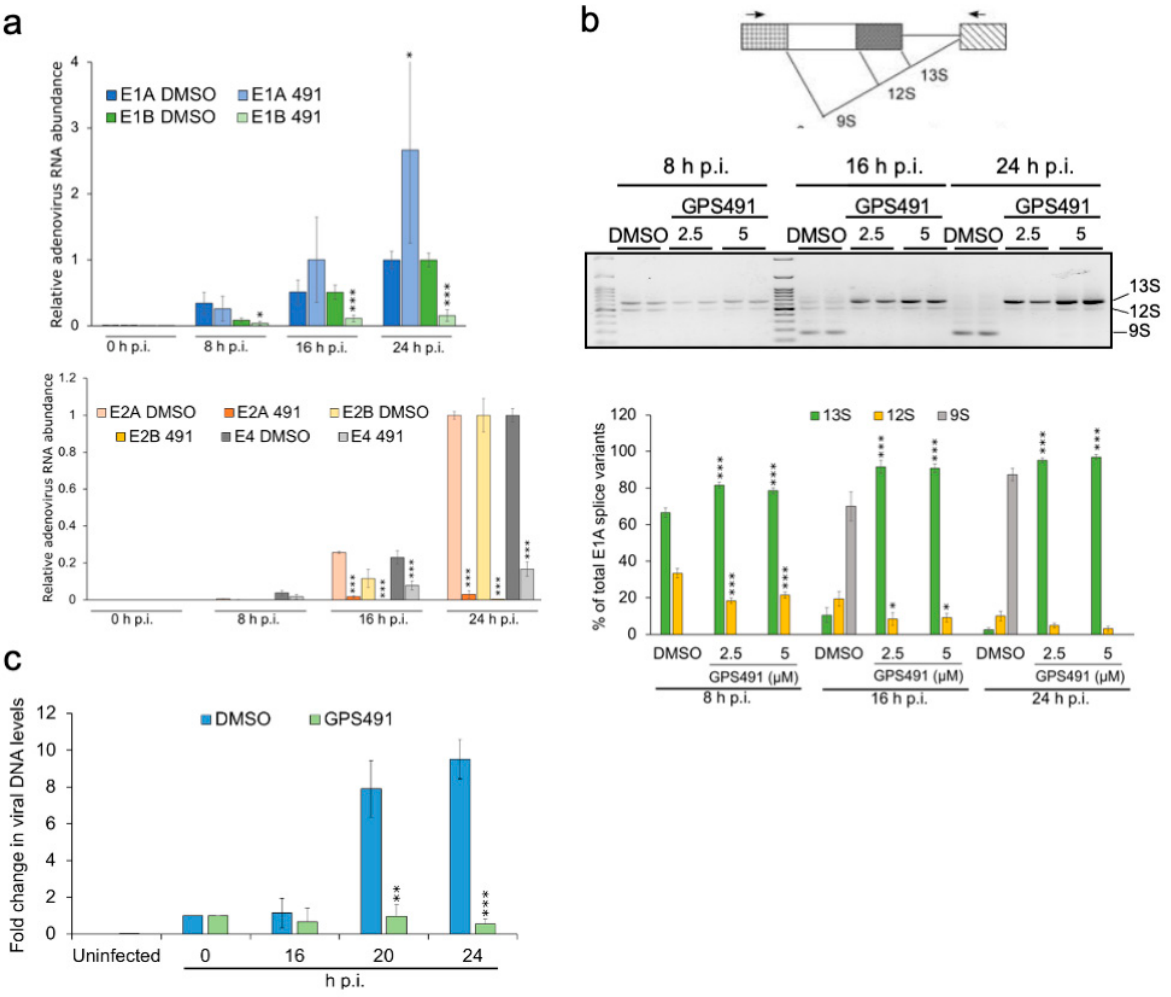
Figure 5. GPS491 alters adenovirus RNA expression/processing and inhibits adenovirus DNA amplification. A549 cells were infected with HAdV-C5 at an input MOI of 100 IU/cell for 1 h after which virus inoculum was removed and replaced with media containing DMSO or GPS491 (2.5 or 5 µM). ( a ) Total RNA was extracted at 8 h, 16 h, or 24 h after virus infection. After cDNA generation, RT-qPCR was performed using primers for E1A, E1B, E2A, E2B, and E4 RNAs (Supplementary Table S1). Values are expressed relative to RNA abundance observed 24 h p.i. in the presence of 1% DMSO. Shown are data from samples treated with 2.5 µM GPS491. ( b ) The effect of GPS491 on E1A RNA processing. Shown on the top is the schematic diagram of E1A RNA processing indicating the major E1A mRNA isoforms generated by alternative splicing. In the middle is a representative gel of the E1A RNA amplicons generated from cDNA. The graph on the bottom represents quantitation of amplicons generated across n > 3 independent assays. ( c ) At 16 h, 20 h, and 24 h p.i., total DNA was isolated from cells treated with DMSO or 2.5 µM GPS491 and levels of adenoviral DNA were determined by qPCR. Data are indicated as mean ± SD, * p ≤ 0.05, ** p ≤ 0.01, and *** p ≤ 0.001.